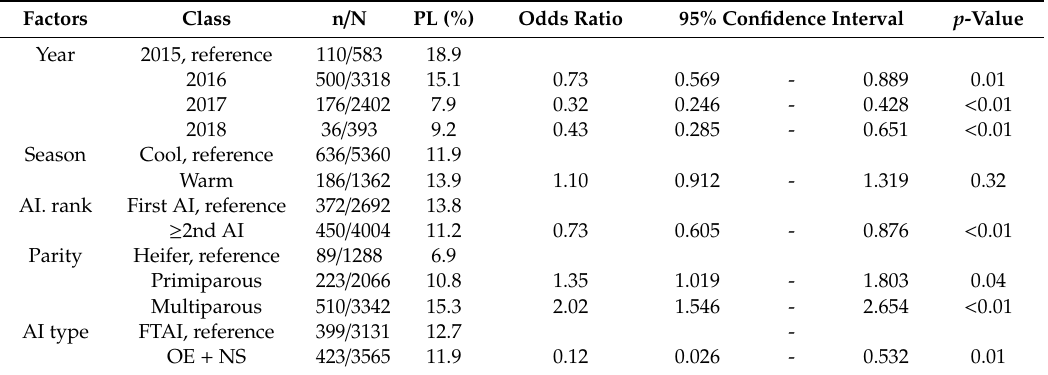
Table 5. Logistic regression statistics for pregnancy loss across eight Spanish Holstein